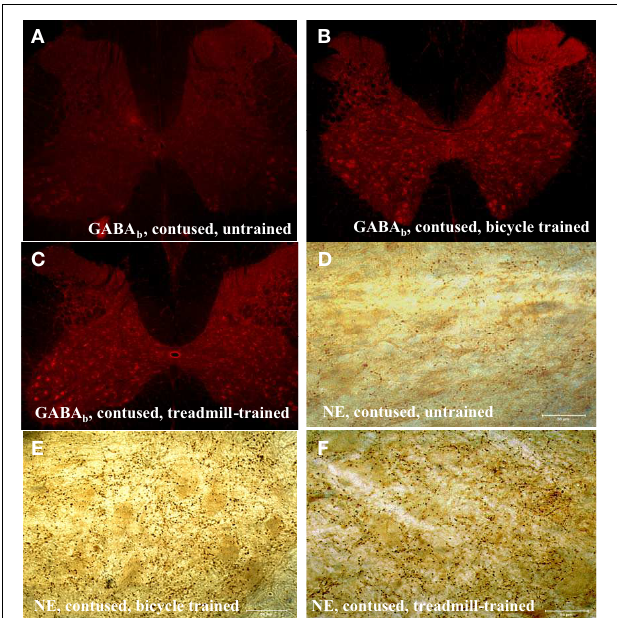
FIGURE 8 | Immunohistochemistry of lumbar spinal cord showing upregulation of GABA b receptors [5 × magnification in (A–C)], and sprouting of dopamine-beta-hydroxylase (DBH) positive noradrenergic (NE) projecting fibers in the ventral horn of the lumbar spinal cord in both types of locomotor training (E,F) compared with contused untrained controls (D; scale bar, 50 µ m).